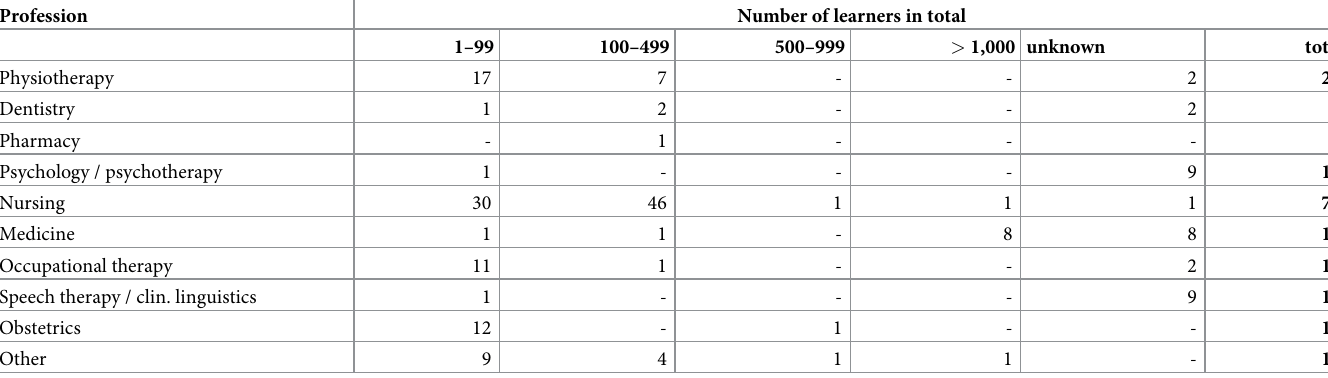
Table 1. Professions trained at institutions by number of learners in total [multiple answer options, sample n = 100].